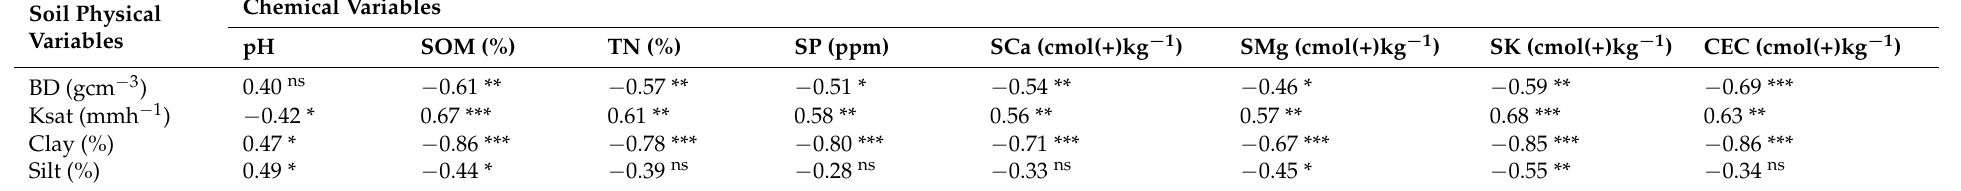
Table 4. Correlation between soil chemical and physical variables.